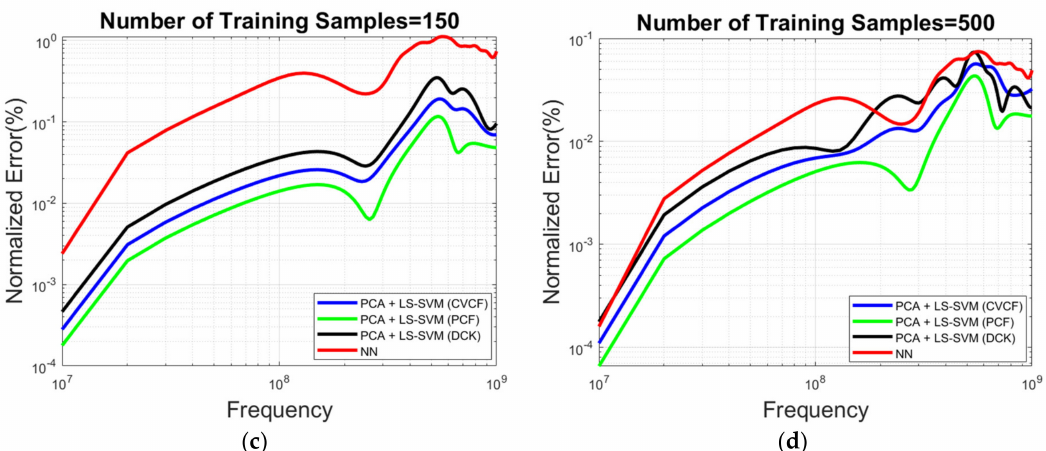
Figure 7. Comparison of the relative NRMSE values computed via the proposed approaches and a feedforward multi-output neural network on the test samples by considering the imaginary part of the transfer function of high-speed link for an increasing number of training samples. ( a ) L = 20; ( b ) L = 100; ( c ) L = 150; ( d ) L = 500).